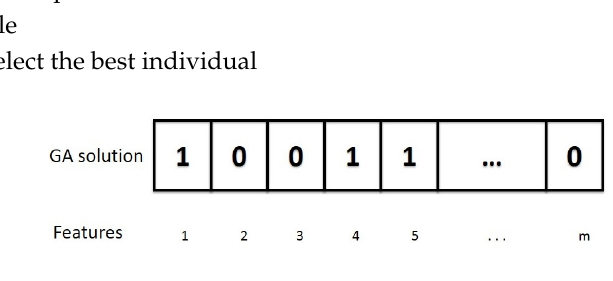
Figure 6. GA feature set solution representation.